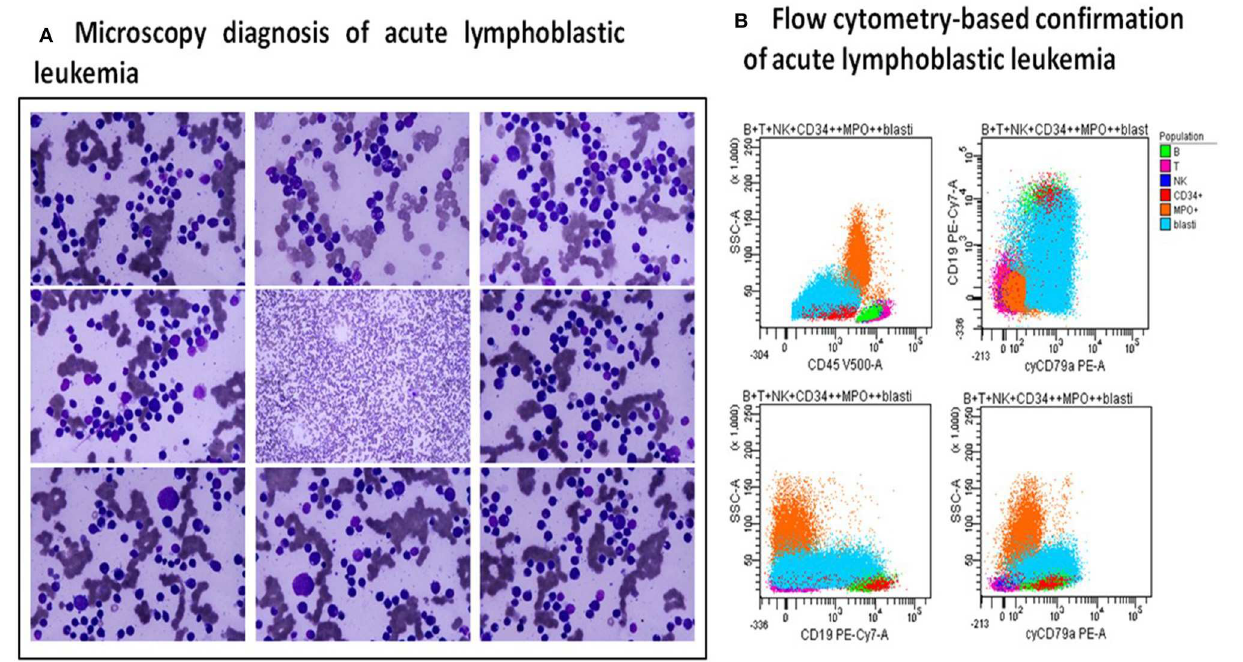
FIGURE 2 | Diagnosis of B-cell